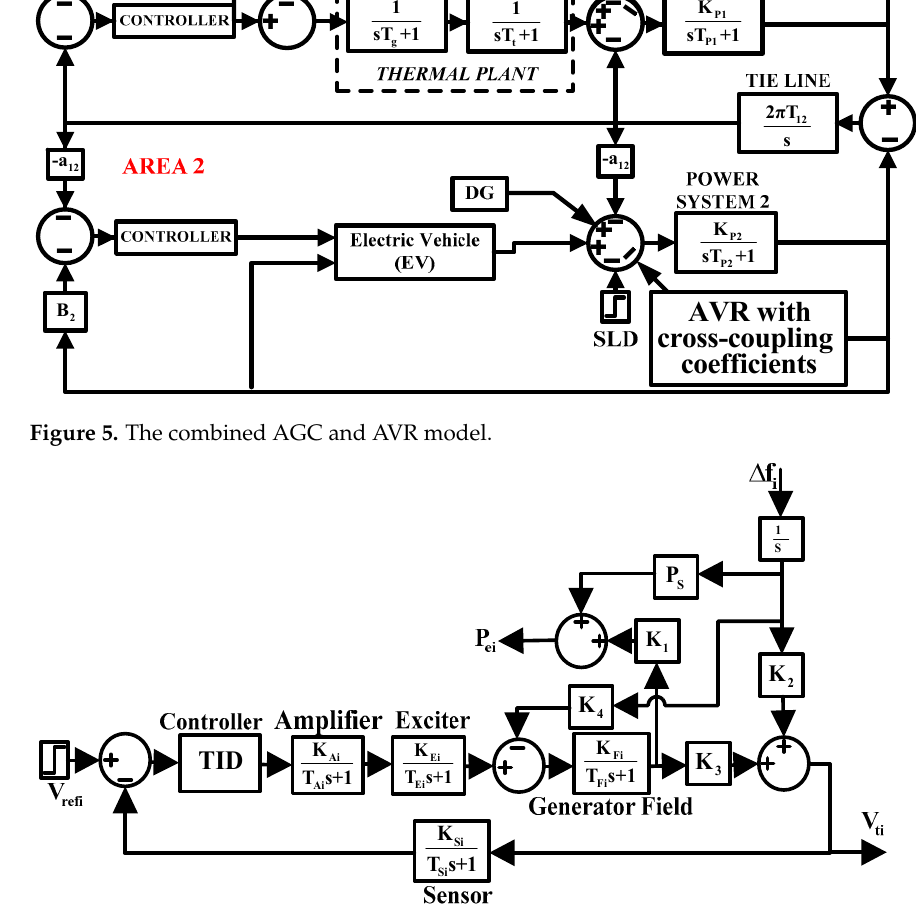
Figure 6. The AVR model with cross-coupling coefficients.